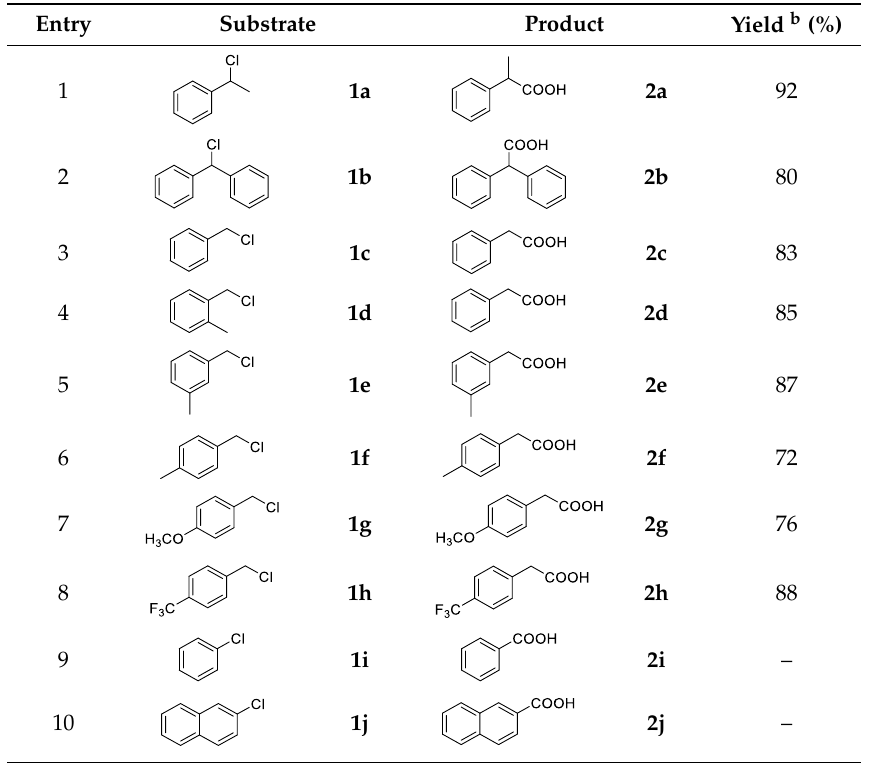
Table 2. Electrocatalytic carboxylation of other benzyl chlorides on Cu foam cathode a